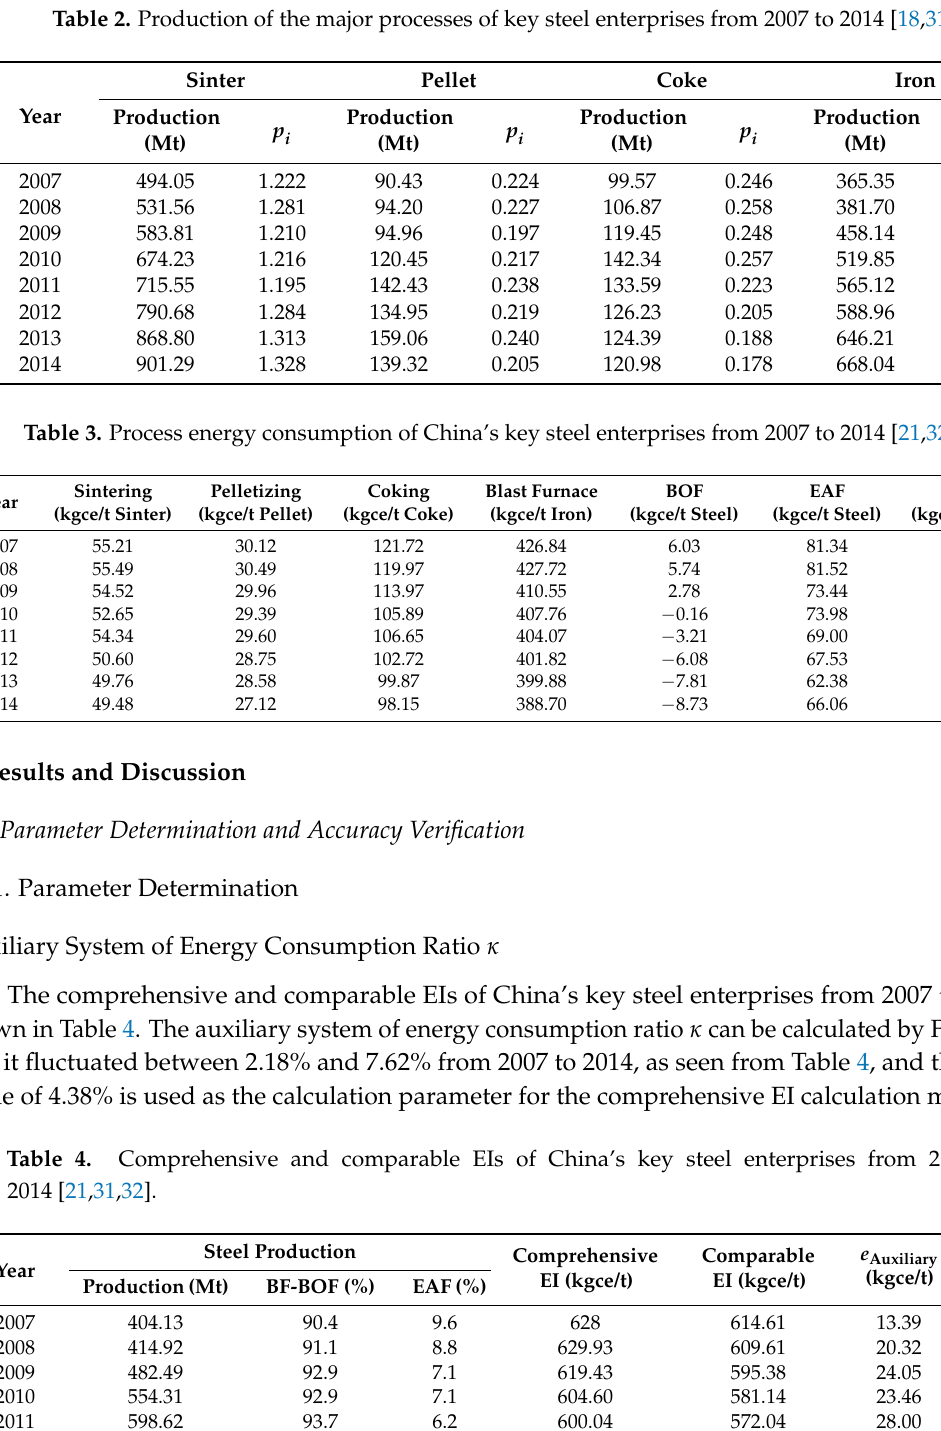
Table 2. Production of the major processes of key steel enterprises from 2007 to 2014 [18,31].